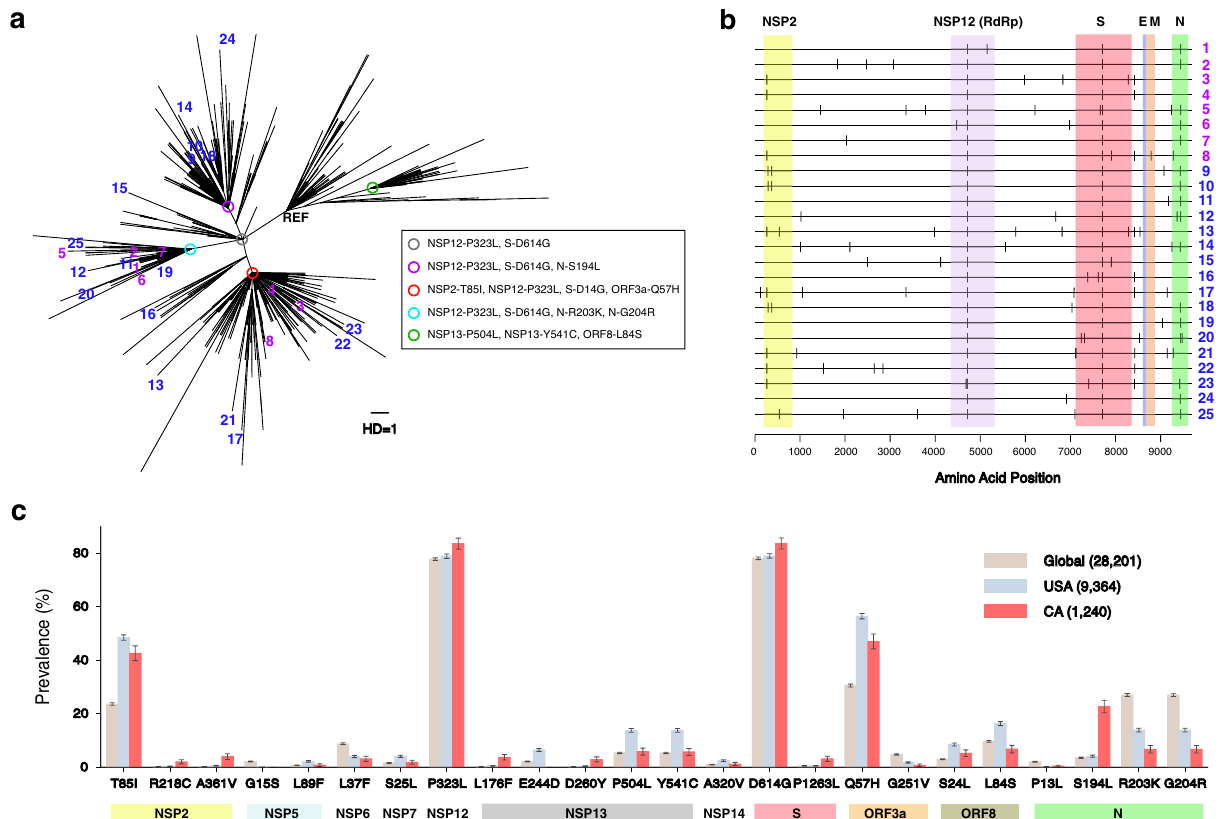
Figure 2. Maximum likelihood tree analysis and amino acid mutations of 25 SARS-CoV-2 whole genome sequences obtained by CorvGenSurv. (a) Maximum likelihood tree of 25 SARS-CoV-2 sequences obtained by CorvGenSurv along with sequences collected in California, US. A total of 1215 SARS-CoV-2 sequences collected from California, USA were downloaded from GISAID 20,21 as of July 27th, 2020. Our sequences were obtained from 25 remnant specimens from COVID-19 testing between April 13th and June 22nd, 2020 from Los Angeles County, California, USA. Specimens collected from April to May 2020 were colored purple and those collected in June were colored blue. Sequences of specimens USA/CA-LAC-USC1 to USA-CA-LAC- USC25 in Table 1 were denoted by 1 to 25 in this tree. All 25 sequences were classified as G clade with mutations P323L in NSP12 (RdRP) and D614G in S protein (grey circle). Different ancestral sequences were presented by circles in different colors with common mutations of each lineage presented in the box. The unit branch length (one nucleotide base substitution) was denoted as “HD = 1”. ( b) Each of our 25 sequences’ amino acid mutations from Wuhan-Hu-1 (MN908947) were marked using Highlighter (https:// www. hiv. lanl. gov/ conte nt/ seque nce/ HIGHL IGHT/ highl ighter_ top. html). The regions of NSP2, NSP12 (RdRP), S, E, M, and N were presented by colored boxes. ( c) The prevalence of each amino acid mutation with greater than 2% frequency either globally, in the USA, or in California. A total of 28,176 global sequences were downloaded from GISAID 20,21